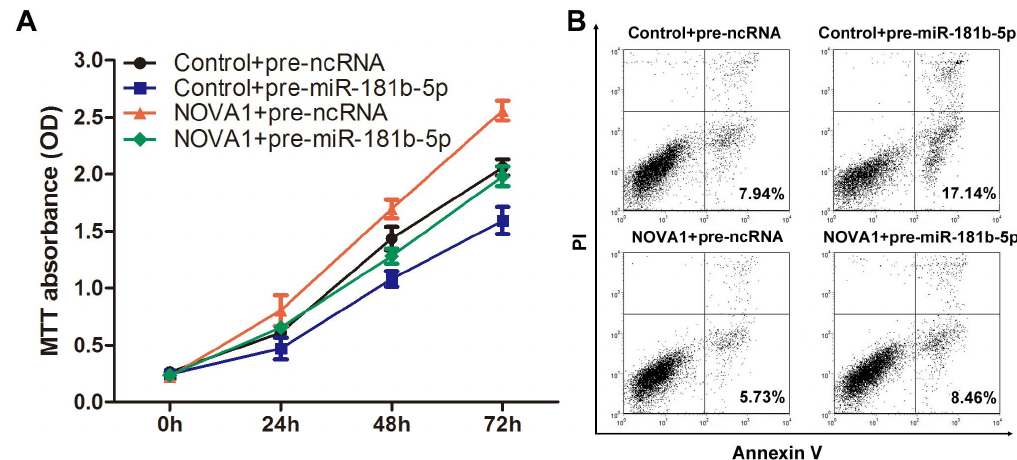
Figure 5. Overexpression of NOVA1 reversed the inhibitory effects of miR-181b-5p. (A) Cell proliferation assay. An MTT cell viability assay was performed at 0, 24, 48 and 72 h after the transfection of U251 cells with control vector + pre-ncRNA, control vector + pre-miR-181b-5p, NOVA1 vector + pre-ncRNA, and NOVA1 vector + pre-miR-181b-5p. The experiment was repeated three times. (B) Cell apoptosis assay. U251 cells were transfected with control vector + pre-ncRNA, control vector + pre-miR-181b-5p, NOVA1 vector + pre-ncRNA, and NOVA1 vector + pre-miR-181b-5p. The experiment was repeated three times, and representative data were shown.